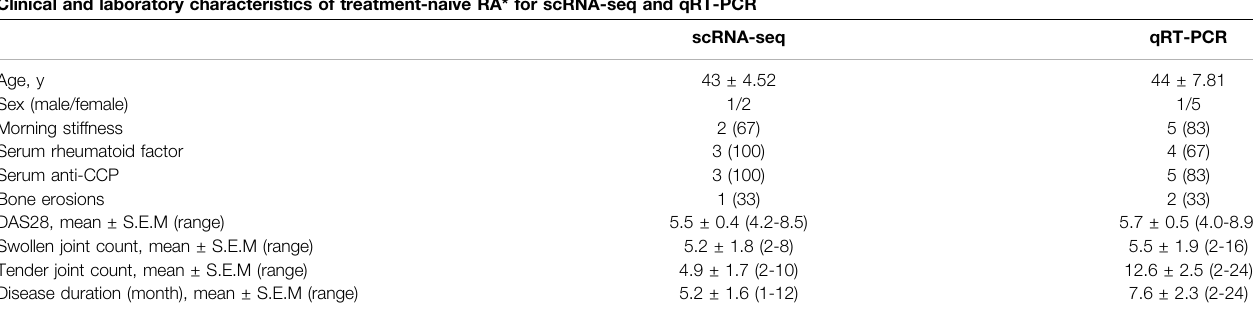
TABLE 1 | General information of early treatment-naïve RA patients used for scRNA-seq and qRT-PCR analysis. Clinical and laboratory characteristics of treatment-naïve RA* for scRNA-seq and